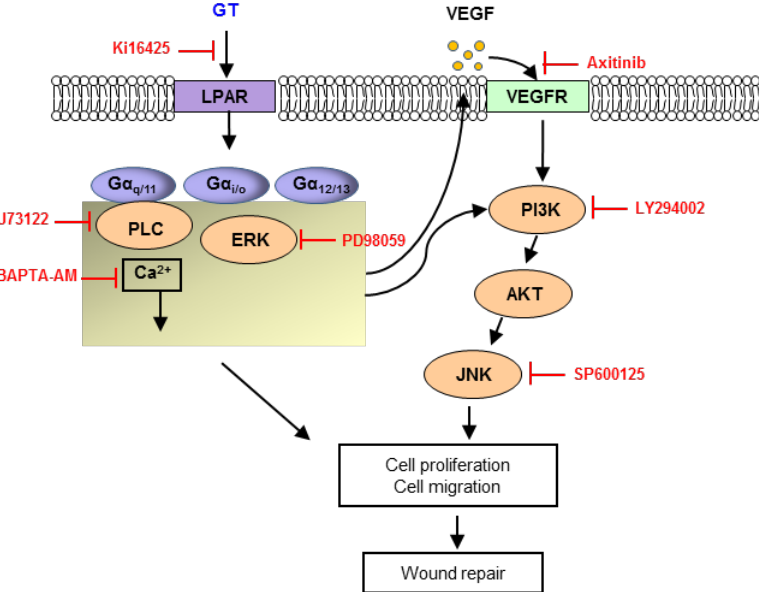
Figure 7. Prospective signaling pathways for gintonin-induced wound repair of keratinocytes. Lysophosphatidic acid (LPA) receptor activation by gintonin (GT) may activate protein kinase C (PKC)/extracellular signal-regulated kinase (ERK), phospholipase C (PLC)/intracellular Ca 2+ mobilization through G-proteins, leading to keratinocyte proliferation and migration as well as vascular endothelial growth factor (VEGF) release. VEGF may also activate VEGF receptor/ phosphoinositide 3-kinases (PI3K)/ protein kinase B (AKT)/ c-Jun N-terminal kinase (JNK), leading to keratinocyte proliferation and migration. Ultimately, these signaling pathways may promote skin wound repair. LPAR, lysophosphatidic acid receptor; VEGFR, vascular endothelial growth factor receptor.